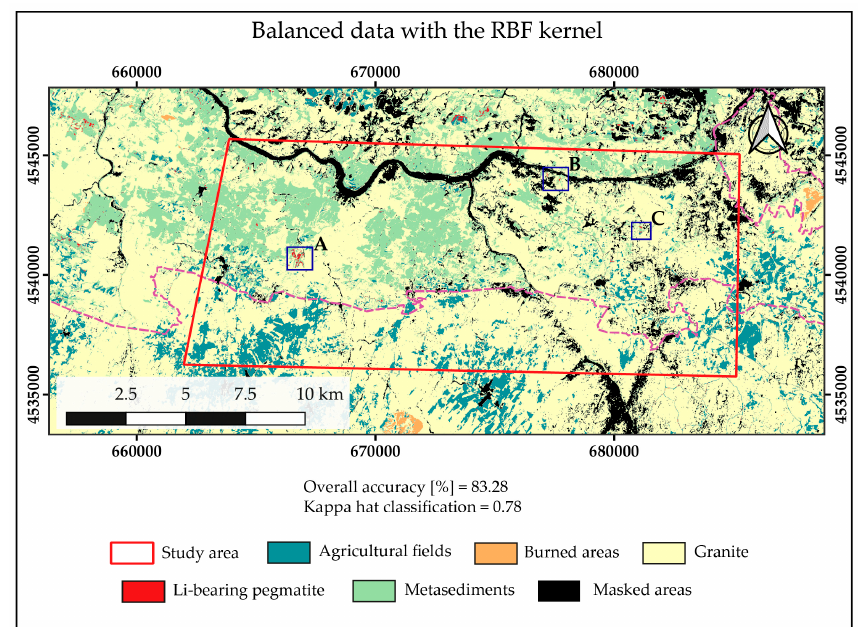
Figure 8. Final classification map based on the RBF-SVM model built with the balanced data. A—Bajoca mine, B—Feli mine, and C—Alberto mine. Dashed purple line: simplified contact between the Metasediments and the Granite. Zoom images of the open-pit mines can be found in Figure 9. The comparison between the two classification maps indicated that the overall performance of each class changed from one model to the other. For example, the RBF-SVM model was able to